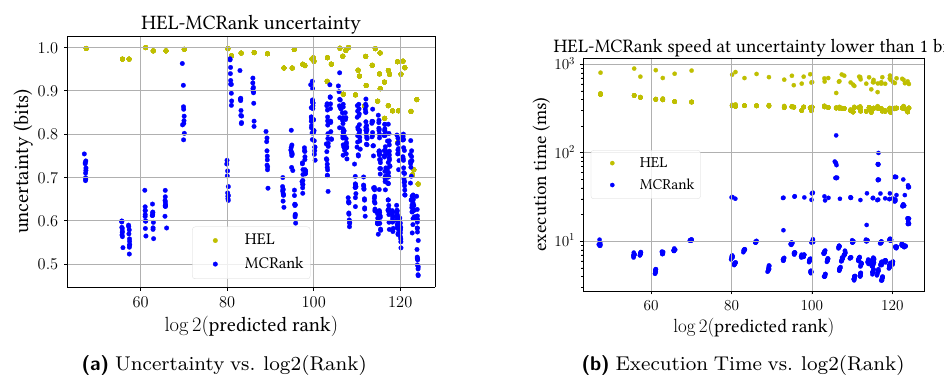
Figure 3: AES-128. Comparison between Histogram Enumeration and MCRank . MCRank is orders of magnitude faster (b) while achieving comparable uncertainty (a).